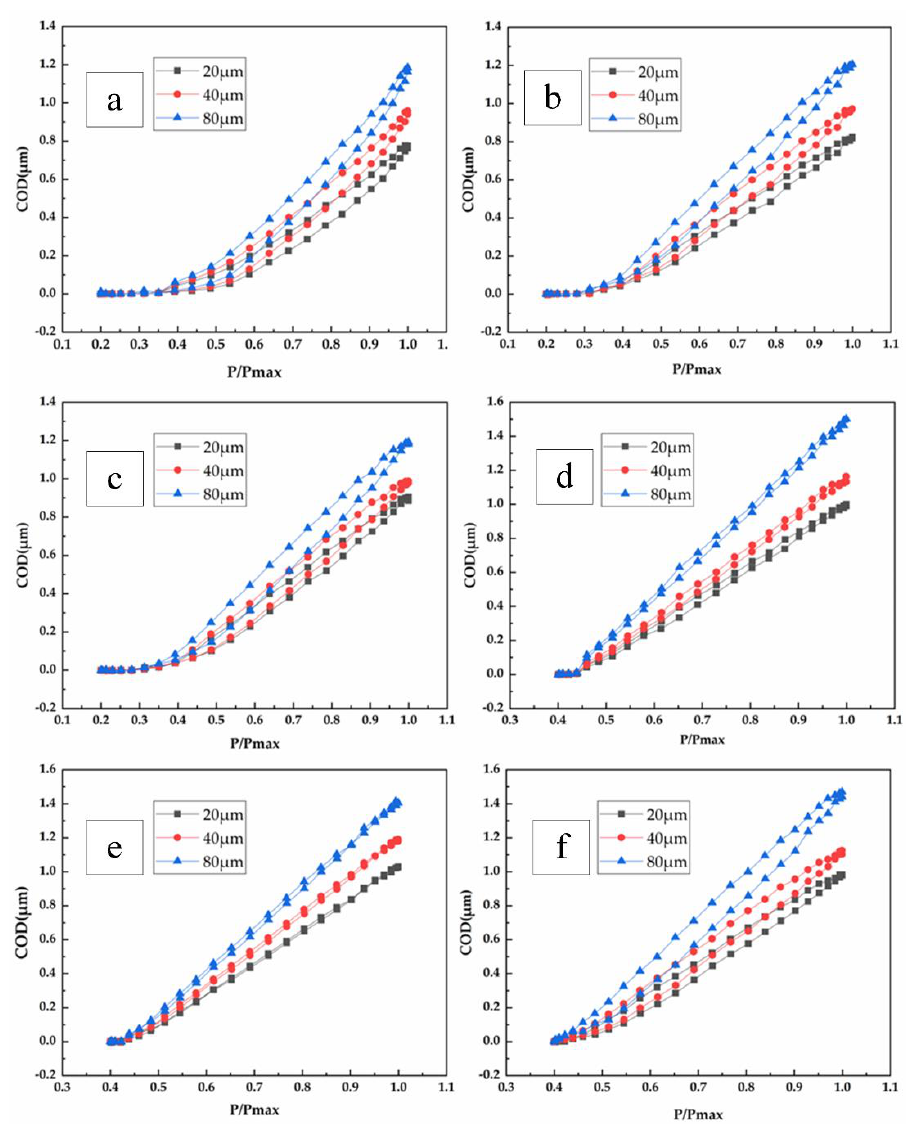
Figure 11. P/Pmax- Δ COD curves of different lengths at stress ratio of 0.2: ( a ) crack length 0.374 mm, ( b ) crack length 0.919 mm, and ( c ) Crack length 1.457 mm. P/Pmax- Δ COD curves of different lengths at stress ratio of 0.4: ( d ) crack length 0.314 mm, ( e ) crack length 0.859 mm, and ( f ) crack length 1.507 mm.